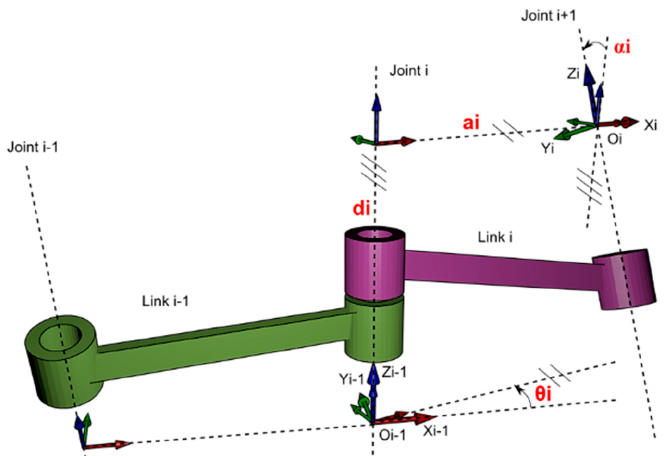
Figure 5. Parameter definitions of the Denavit–Hartenberg representation of a kinematic linkage chain. For the case of the LR-Mate 200iD/4S, the DH parameters for the articulated robot are displayed in Table 2. J1-6 are the six links of the robot, and J7 is the end effector. Table 2. DH parameters for the LR-Mate 200iD/4S [22].